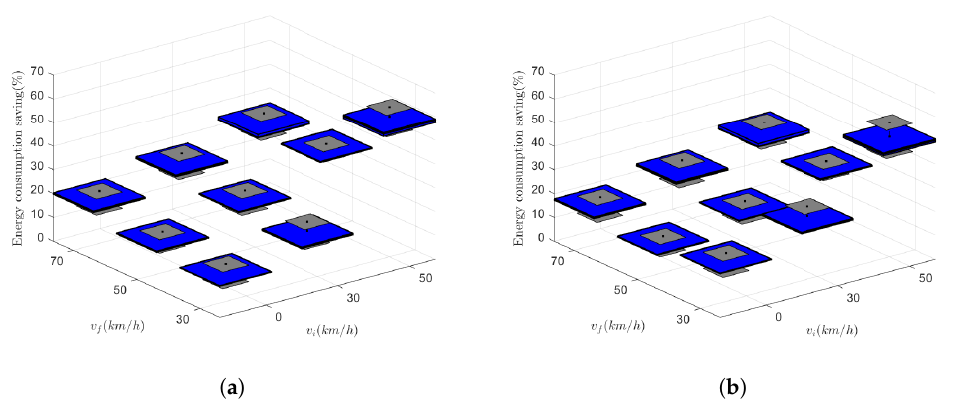
Figure 4. Energy consumption savings of the eco-FF model with respect to the Gipps model with low and high auxiliary power consumption levels. ( a ) c 4 = 970 (W). ( b ) c 4 = 2550 (W).